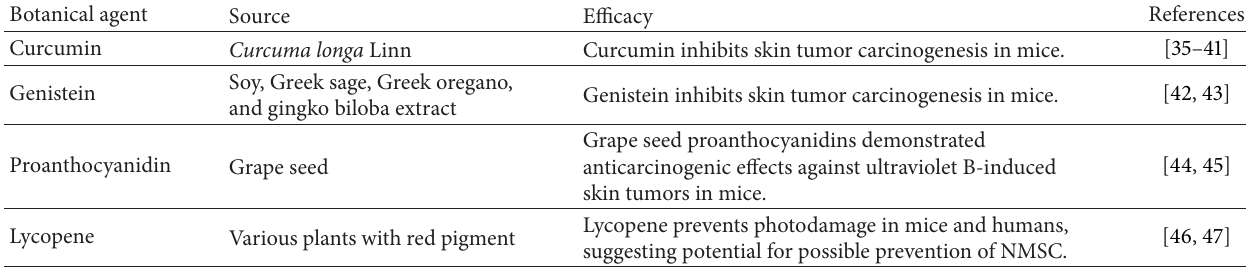
Table 3: Summary of the effects of botanical agents investigated only in preclinical